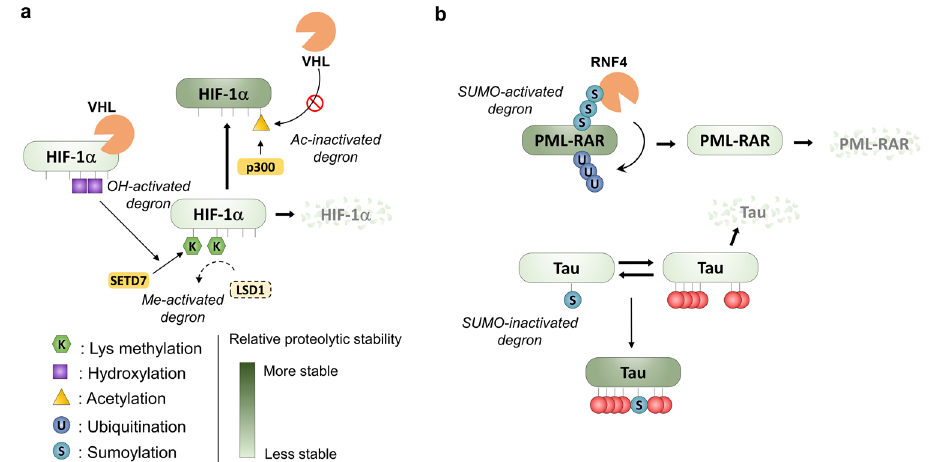
Fig.4|Proteinstabilitycontrolledbymethylation,acetylation,hydroxylation, and SUMOylation. a HIF-1 α is regulated by acetyl-inactivated degron, hydroxyl- activated degron, and methyl-activated degron. p300 acetyltransferase generates acetyl-inactivated degron of HIF-1 α and HIF-1 α acetylation triggers stabilization in